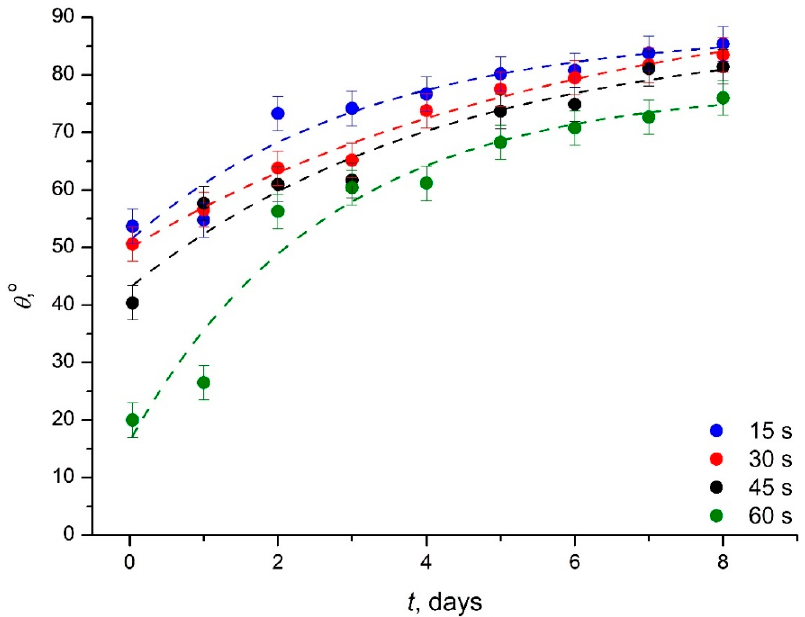
Figure 6. Kinetics of the hydrophobic recovery of PVC following the radiofrequency plasma treatment is depicted. Blue circles correspond to the 15 s treatment; red circles correspond to the 30 s treatment; black circles correspond to the 45 s treatment; and green circles correspond to the 60 s treatment. The dashed line corresponds to the exponential fitting with Equation (5). The parameters of fitting are supplied in Table 3.